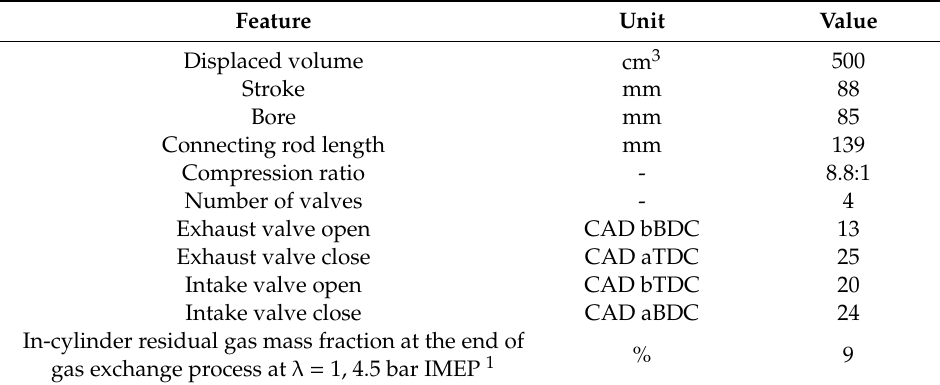
Figure 1. ( a ) Test engine; ( b ) details of engine head. Table 1. Engine specifications. CAD—crank angle degree.